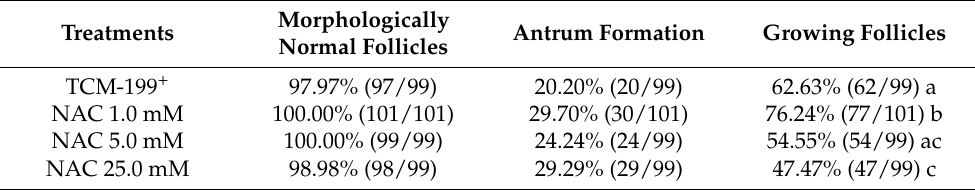
Table 2. Diameters (mean ± SEM) of bovine secondary follicles after 0 and 18 days of in vitro culturing in TCM-199 + alone or supplemented with different concentrations of NAC. Growth Daily Growth Treatments Day 0 Day 18 Day 0–18 Average ( µ m) 203.69 ± 3.52 a 279.46 ± 8.21 b TCM-199 + 75.77 ± 7.46 4.21 ± 0.41 ( n = 62) ( n = 62) 201.76 ± 3.04 a 280.77 ± 8.76 b NAC 1.0 mM 82.80 ± 8.51 4.39 ± 0.43 ( n = 77) ( n = 77) 203.40 ± 3.41 a 265.92 ± 8.17 b NAC 5.0 mM 66.42 ± 8.41 3.46 ± 0.41 ( n = 54) ( n = 54) 210.95 ± 4.15 a 271.18 ± 8.81 b NAC 25.0 mM 60.24 ± 7.63 3.34 ± ( n = 47)